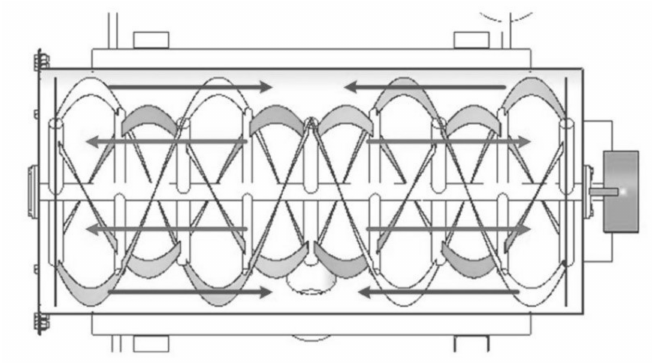
Figure 4. Stirring blade diagram in the fermentation